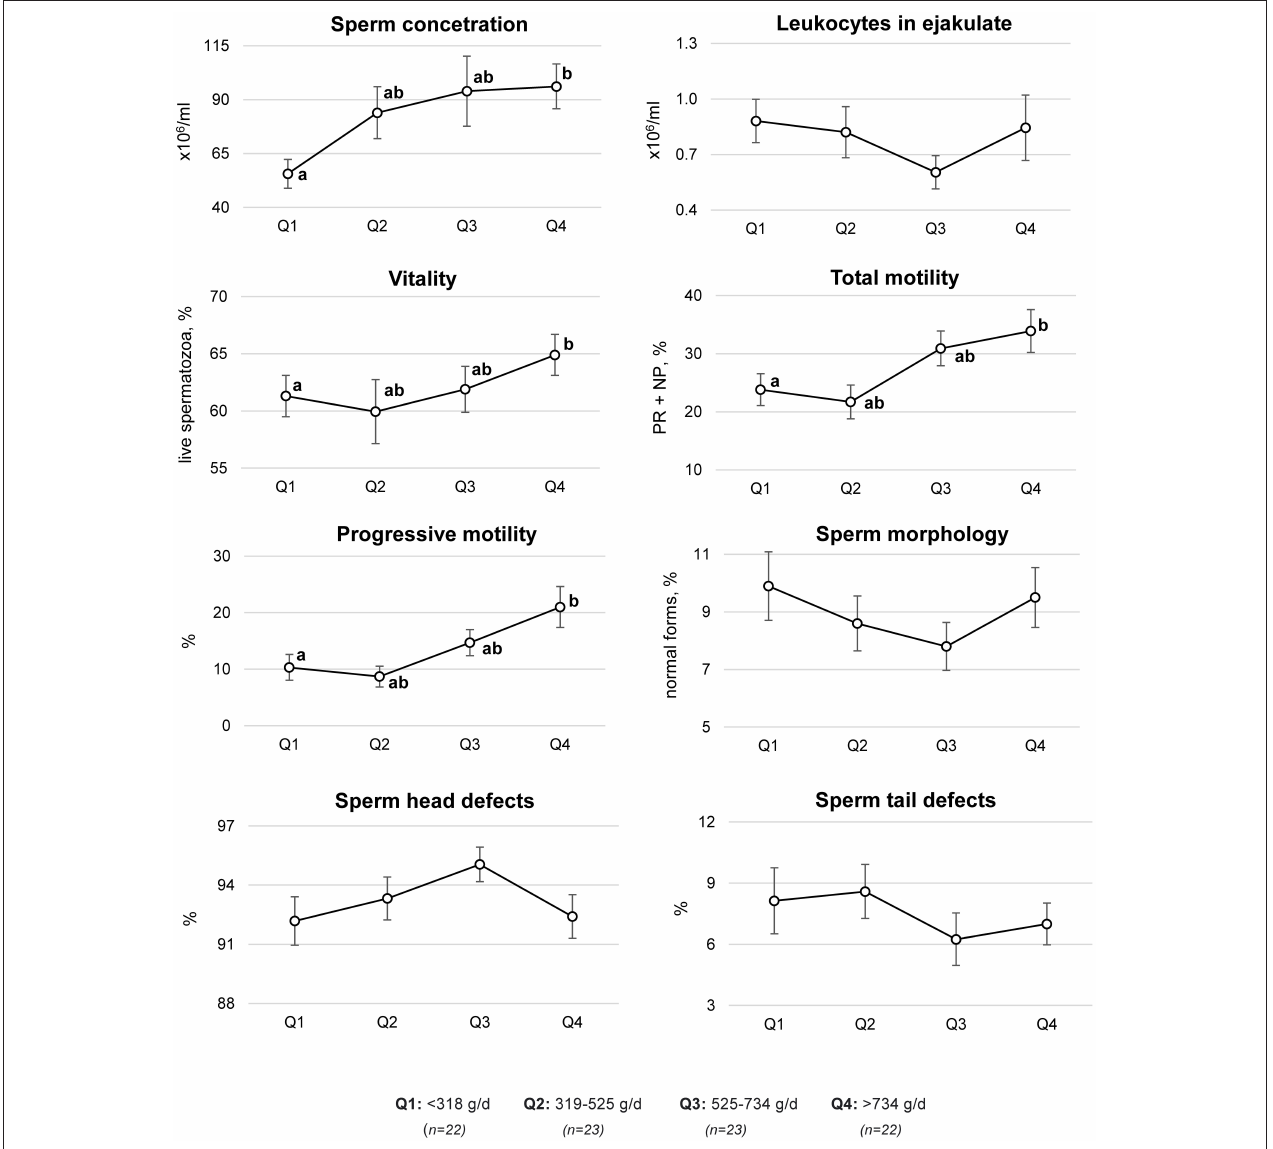
FIGURE 3 | Semen quality parameters by quartiles (Q) of fruit and vegetable consumption. Mean ± SE of semen quality parameters were estimated based on a multivariate regression model adjusted for age (years, continuous), BMI ( < 18.5, 18.5–24.9, and > 24.9 kg/m 2 ), sitting time (h/d, continuous), physical activity level (MET-h/week, continuous), smoking (ever, never), alcohol consumption (ever, never), supplement use (yes, no), wearing briefs and boxer shorts (ever, never), and energy (kcal/d, continuous). PR, progressive motility; NP, non-progressive motility; a , b different letters indicate statistically significant differences between quartiles, p -value ≤ 0.05 (Mann–Whitney